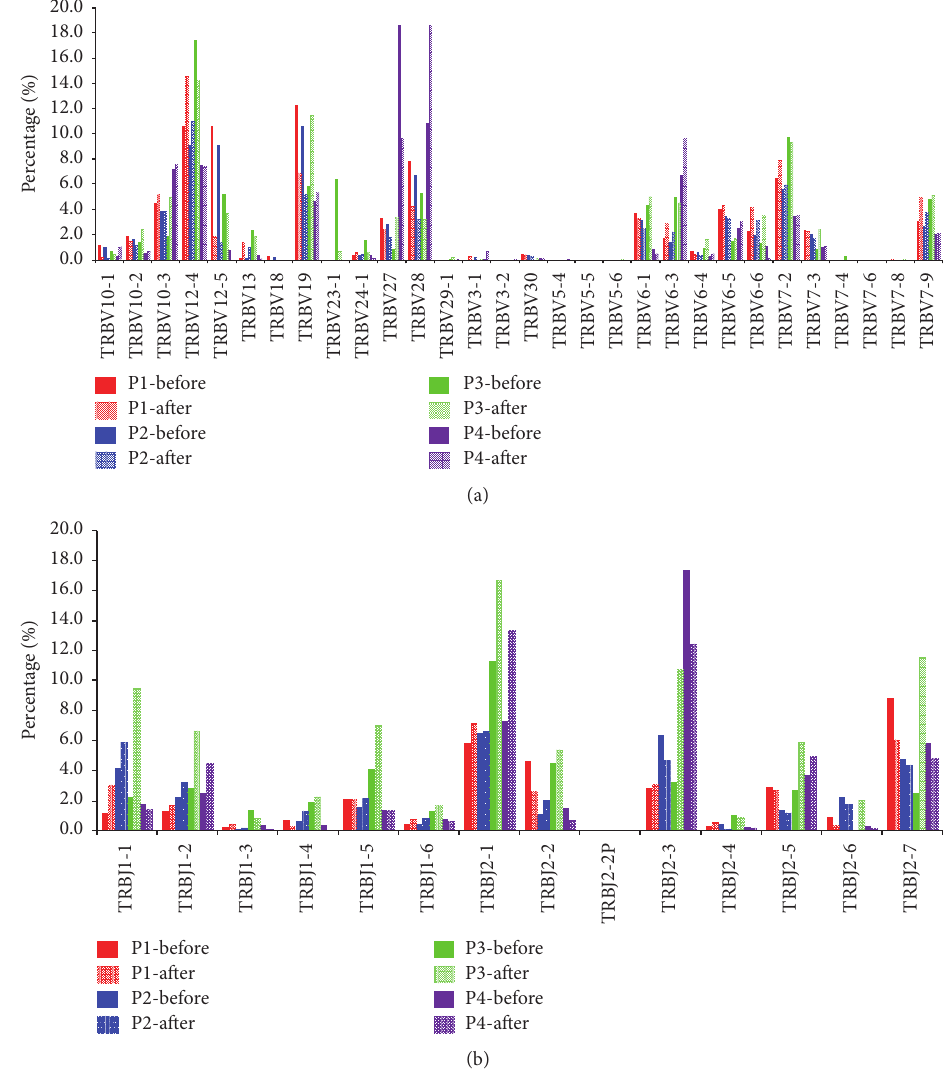
Figure 1: The serial results of relative TCRV 𝛽 and J 𝛽 expression in the four patients (P1–P4) before and after HBeAg seroconversion. (a) The serial results of relative TCRV 𝛽 expression in the four patients (P1–P4) before and after HBeAg seroconversion. (b) The serial results of relative J 𝛽 expression in the four patients (P1–P4) before and after HBeAg